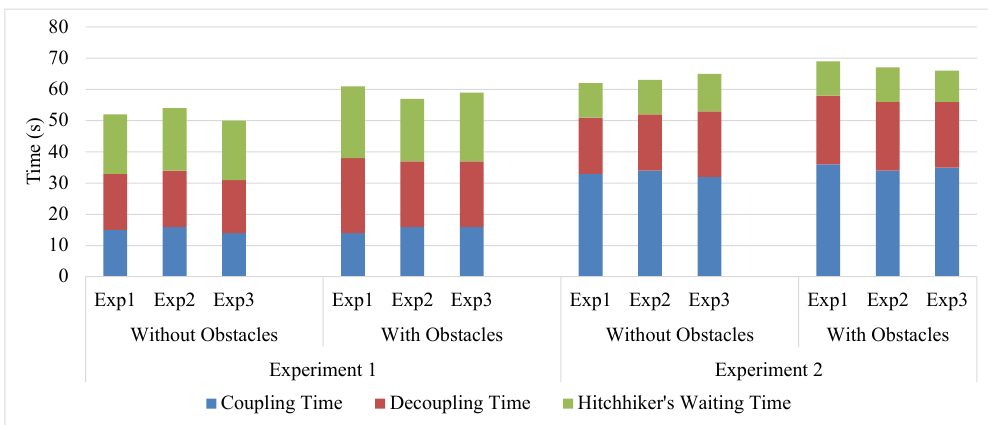
Figure 13. Coupling, decoupling, and hitchhiker’s waiting time in different experiments done with/without new obstacles.